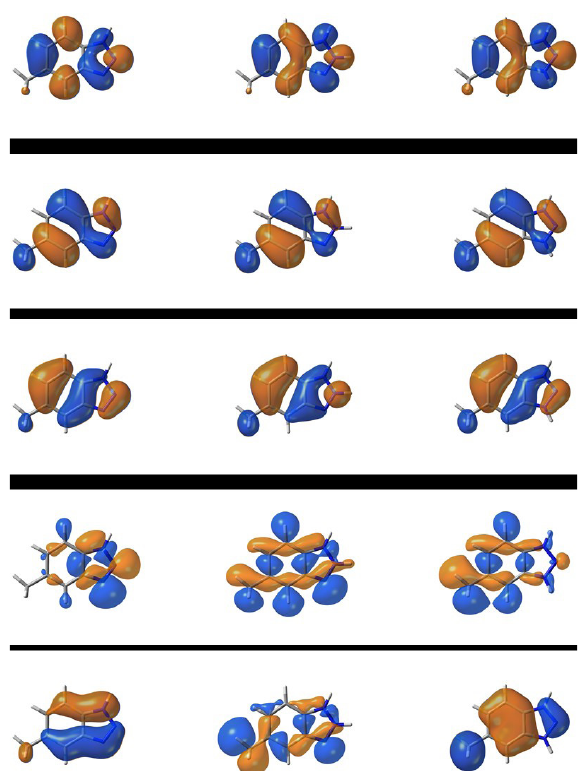
Figure 17. Molecular Orbitals of (a) TTA-5, (b) HTTA + and (c) HTTA